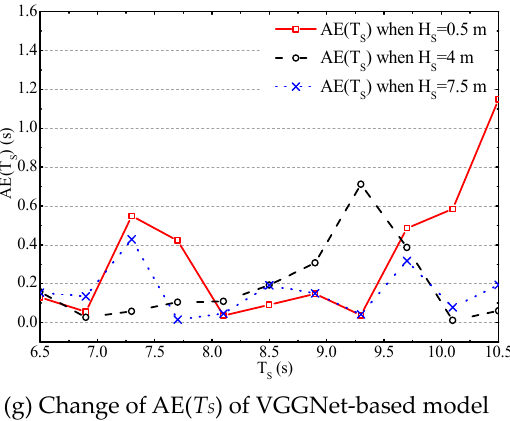
Figure 13. Change of RE and AE with T S for di ff erent H S . Next, T S remained constant and the influence of the change of H S on the CNN-based models was studied. T S was set to 6.5, 8.5 and 10.5 s, and 11 images with different H S were generated under each T S . H S was 0.5, 1.2, 1.9, 2.6, 3.3, 4, 4.7, 5.4, 6.1, 6.8 and 7.5m, respectively. These images were input into the CNN-based inversion models after being cropped. The changes of inversion RE are shown in Figure 14.